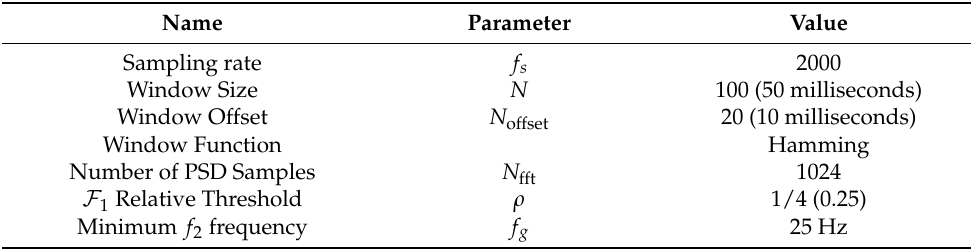
Table 3. Experiment Parameter